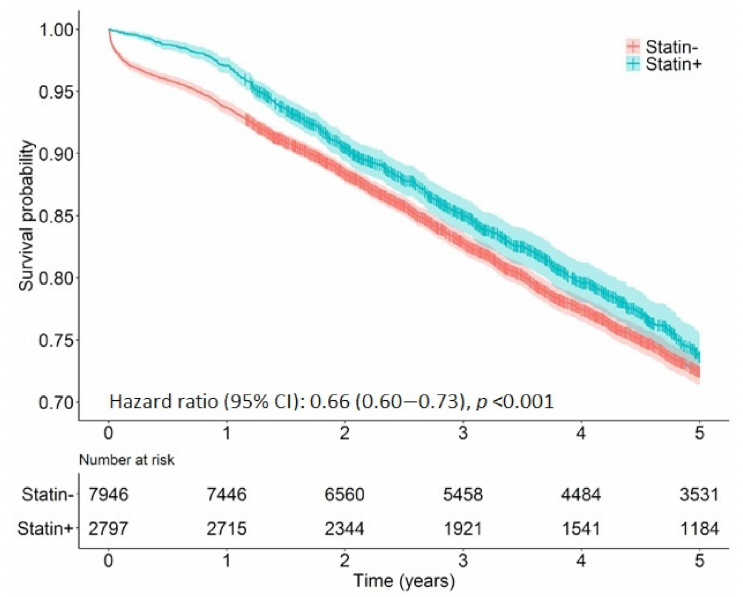
Figure 1. Kaplan–Meier plot of 5-year all-cause mortality for statin users and non-users following surgical resection for rectal